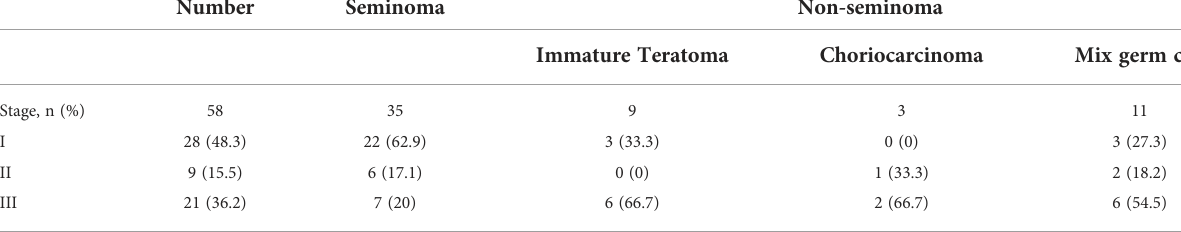
TABLE 1 Demographic and clinicopathologic features of patients with testis